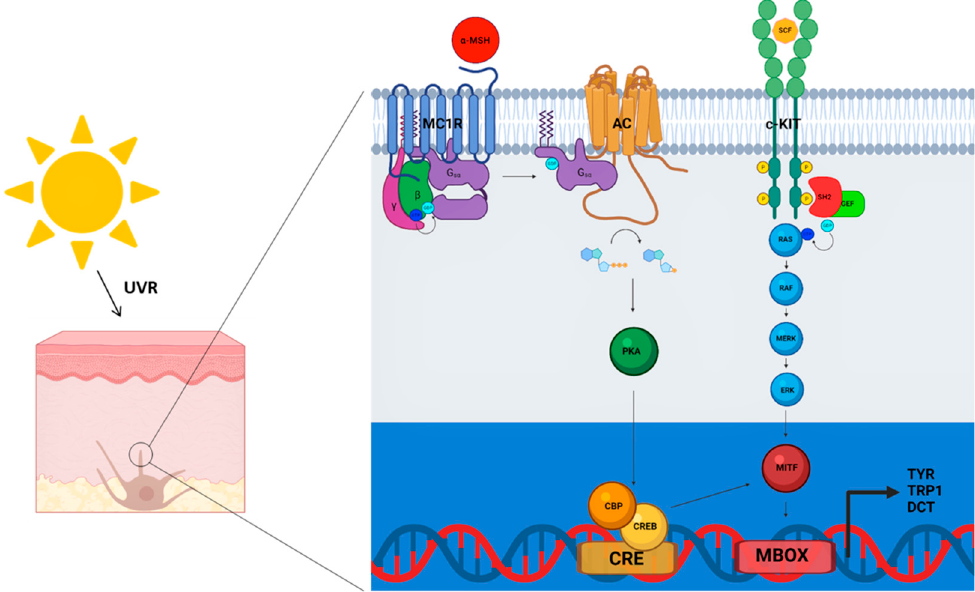
Figure 1. Pigmentary pathway of MC1R. Binding of α -MSH on MC1R receptor activates adenylyl cyclase (AC) and stimulates cAMP production, which in turns induce the activation of several downstream effectors, including MITF transcription factor. MITF binds the MBOX on the promoters of tyrosinase ( TYR ), phosphoribosylanthranilate isomerase ( TRP1 ) and dopachrome tautomerase ( DCT ) genes, leading to the expression of different enzymes involved in melanin biosynthesis. Melanin acts as a UV-protective shield in the epidermis. (G α - β - γ proteins, CREB (cAMP response element binding protein), CBP (CREB-binding protein), CRE (cAMP response elements), c-KIT (tyrosine-protein kinase KIT), SH2 (Src homology 2), GEF (Guanine nucleotide Exchange Factor), MAPK/ERK (extracellular signal-regulated kinases)). This figure was created with BioRender.com.